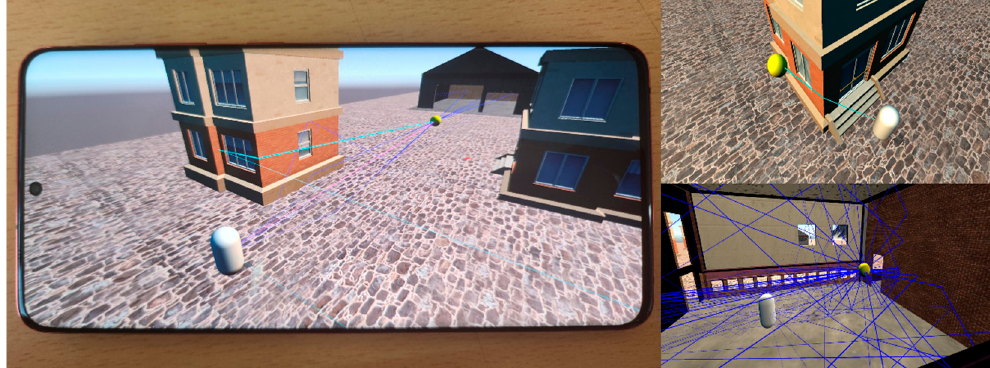
Figure 11. Sound propagation algorithm running on Galaxy S20+.